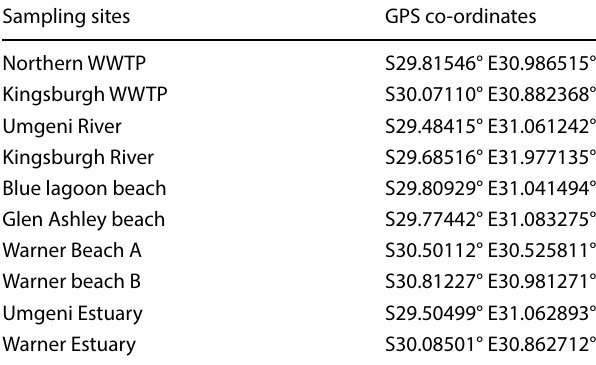
Table 1 Geographical location of sampling sites and corresponding geographic coordinates Sampling